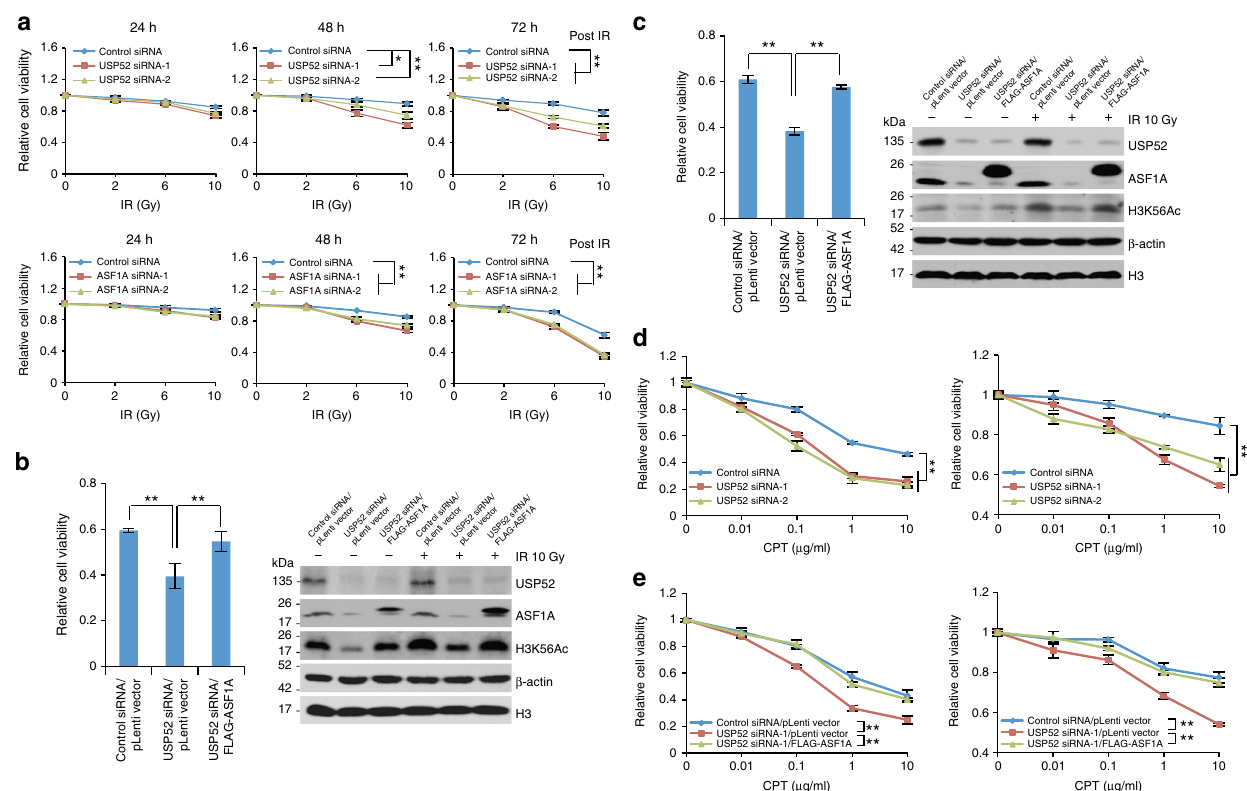
Fig. 7 USP52/ASF1A signaling axis confers DNA damage tolerance. a MCF-7 cells transfected with control siRNA, USP52 siRNA, or ASF1A siRNA were exposed to increasing dosage of IR and cell viability was examined at different time points. Each bar represents the mean ± S.D. for biological triplicate experiments. * P < 0.05, ** P < 0.01, two-way ANOVA. b Control MCF-7 cells or cells stably expressing ASF1A were transfected with control siRNA, or USP52 siRNA. Then cells were exposed to 10 Gy of IR and cell viability was examined. Relative cell viability was calculated with control treatment as a normalizer and each bar represents the mean ± S.D. for biological triplicate experiments. ** P < 0.01, one-way ANOVA. Cellular extracts were collected for western blotting analysis. c Experiments analogous to b were performed with ZR-75-1 cells. ** P < 0.01, one-way ANOVA. d MCF-7 cells (left panel) or ZR- 75-1 cells (right panel) transfected with control siRNA or USP52 siRNA were treated with CPT at indicated dosage and cell viability was examined. Each bar represents the mean ± S.D. for biological triplicate experiments. ** P < 0.01, two-way ANOVA. e MCF-7 cells (left panel) or ZR-75-1 cells (right panel) stably expressing ASF1A were transfected with control siRNA or USP52 siRNA. Then cells were treated with CPT at indicated dosage and cell viability was examined. Each bar represents the mean ± S.D. for biological triplicate experiments. ** P < 0.01, two-way